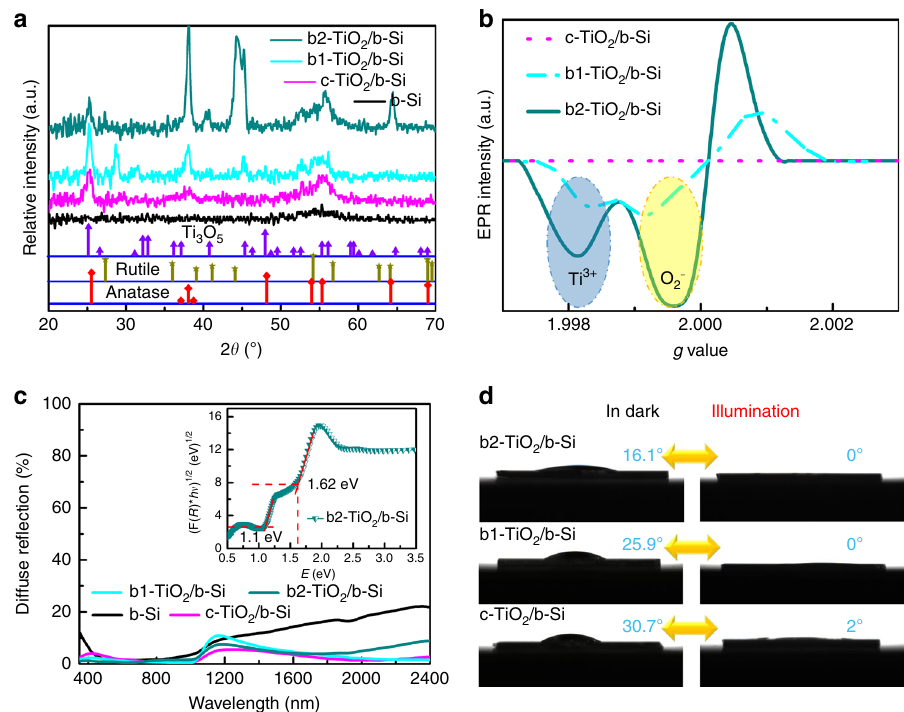
Fig. 2 Structural, optical and wettability characteristics of the samples. a XRD patterns of b-Si (black), c-TiO 2 /b-Si (pink), b1-TiO 2 /b-Si (Cambridge blue) and b2-TiO 2 /b-Si (dark green). The standard XRD patterns for anatase TiO 2 (red rhombus), rutile TiO 2 (tan star) and Ti 3 O 5 (purple triangle) are shown at the bottom (JCPDS, No. 02 – 0387, 03 – 1122 and 23 – 0606), separately. b EPR spectra of c-TiO 2 /b-Si (pink dot), b1-TiO 2 /b-Si (Cambridge blue dash) and b2-TiO 2 /b-Si (green line) at room temperature. c The measured total hemispherical optical re fl ectance of all samples in air. The inset shows the optical absorption coef fi cient as a function of the incident photon energy for indirect allowed transition for b2-TiO 2 /b-Si. d Photographs of the spherical water droplets with changeable CAs before and after c-TiO 2 /b-Si, b1-TiO 2 /b-Si and b2-TiO 2 /b-Si were exposed to UV-visible light irradiation for 30 min,